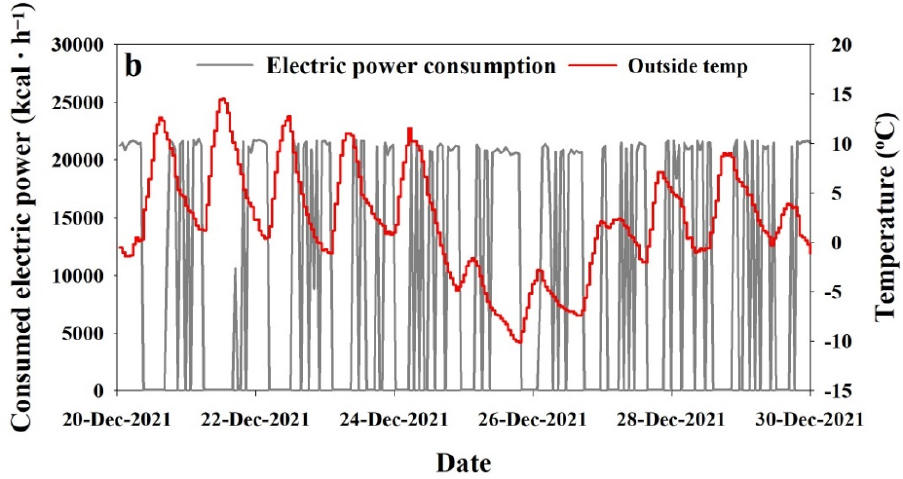
Figure 14. Analysis of heat pump on heating mode ( a ) water temperature and flow rate ( b ) power consumption.